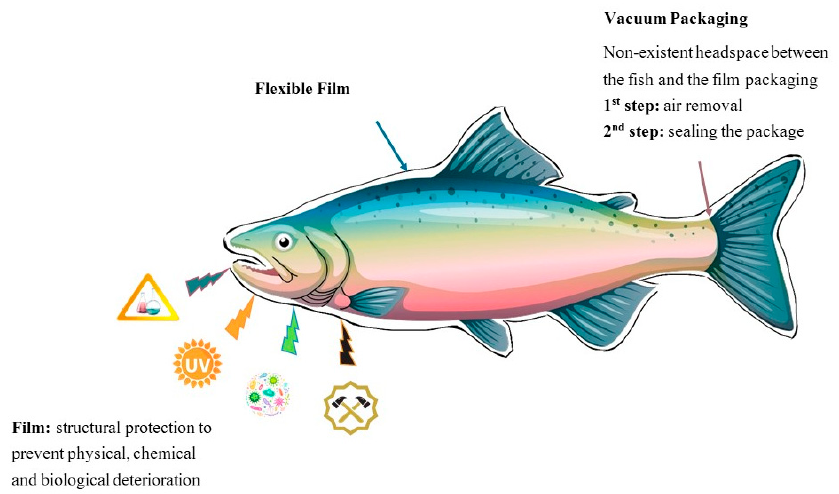
Figure 1. Schematic representation of VP technology applied to fishery products.